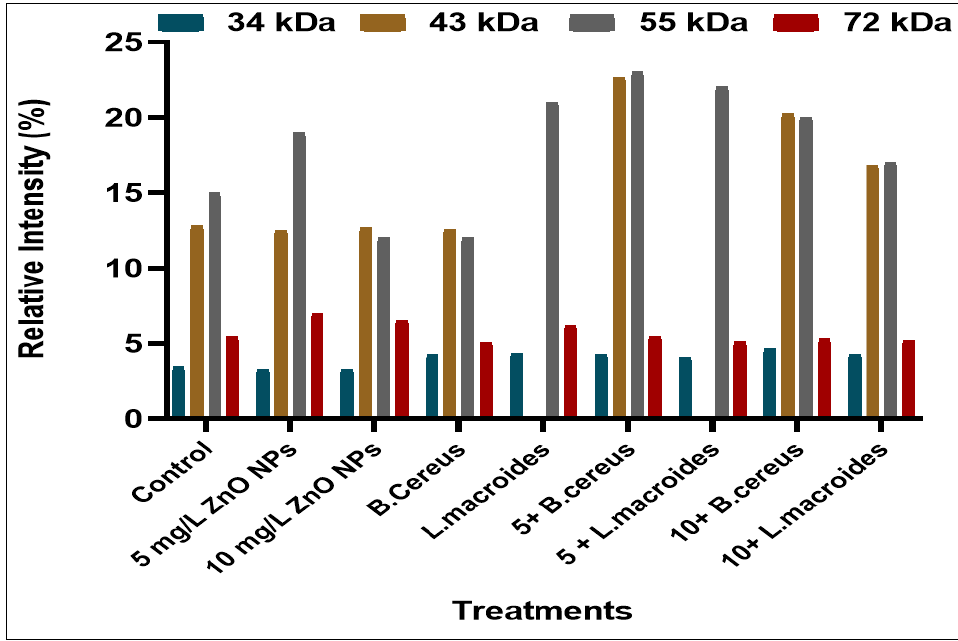
Figure 2. Protein banding intensity of rice plants that were grown by the synergistic treatment of seeds that were primed with bacteria and grown in ZnO NPs alone or in combination with distilled water at marker size (34, 43, 55, and 72